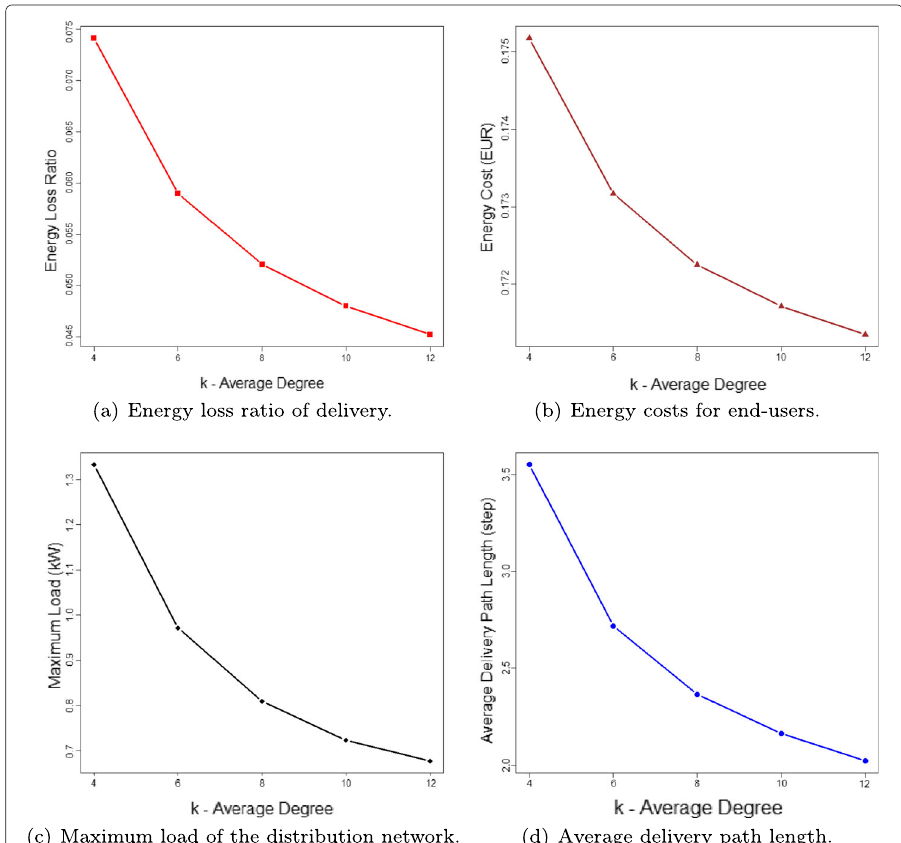
Fig. 7 Parameter influence on the performance of the random graph model